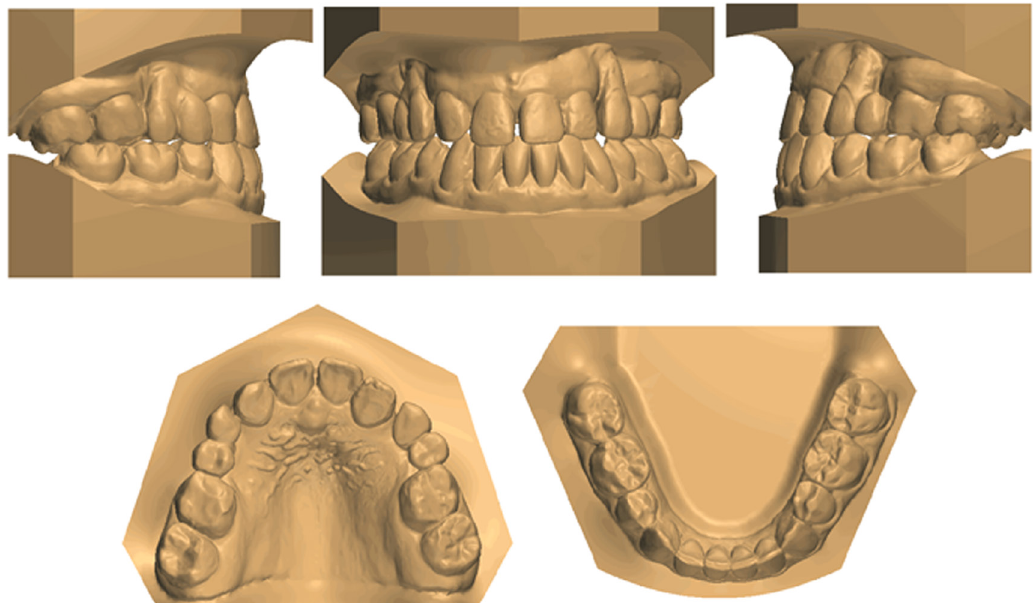
Figure 11. Twenty-four years post-FM cessation dental